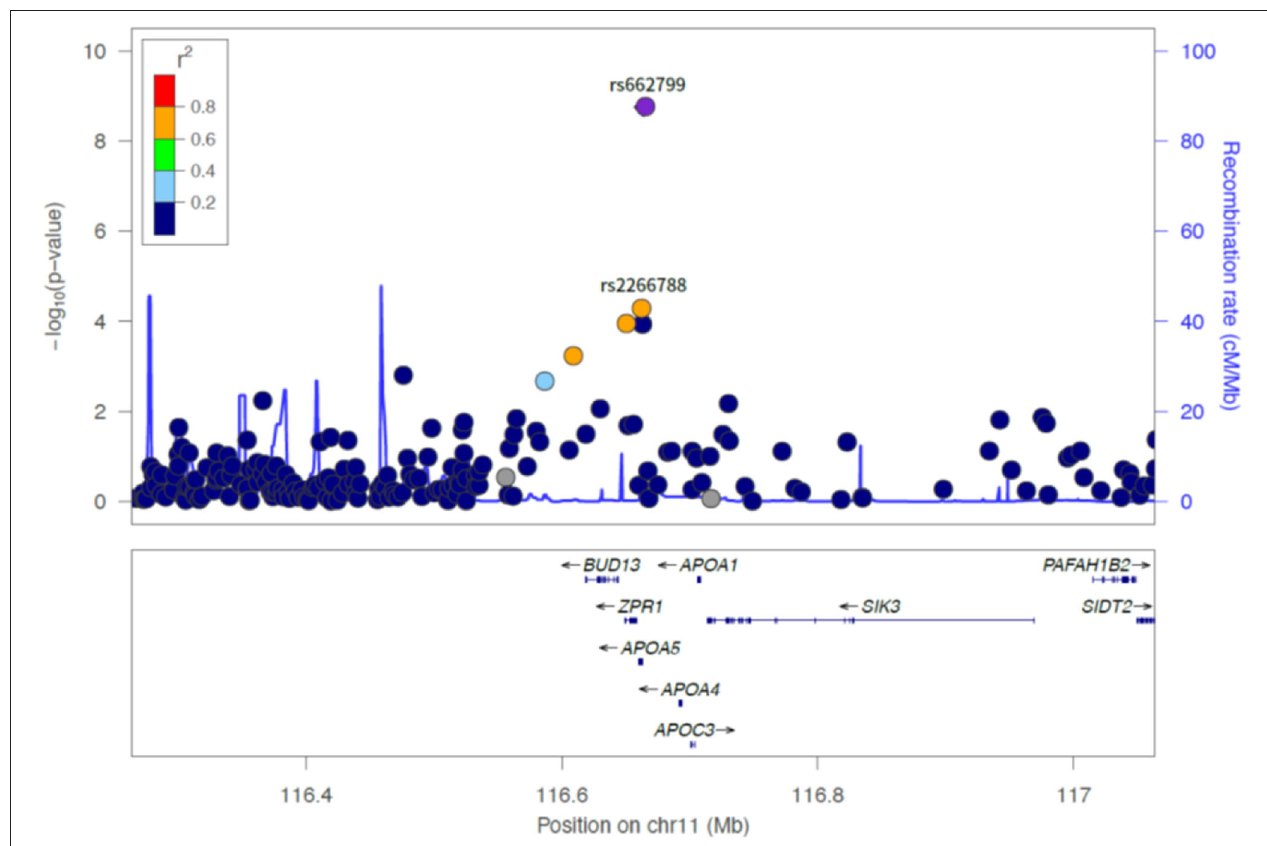
FIGURE 2 | LocusZoom plot showing the region associated with LDL cholesterol variability near rs662799 (APOA5 gene).